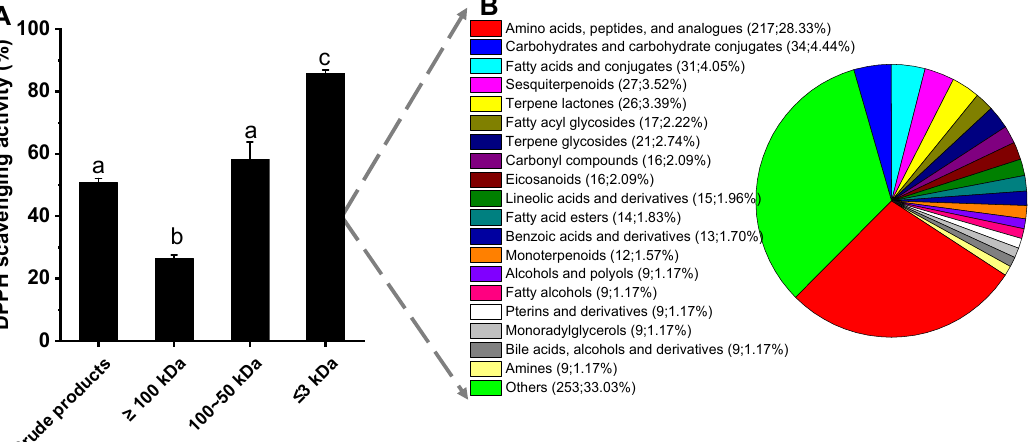
Figure 6. ( A ) The DPPH scavenging activity of fermentation products with different molecular weights. ( B ) Comparison of the relative abundance of metabolites in the low molecular weight ( ≤ 3 kDa) products. The different superscript letters indicate a significant difference at p < 0.05.